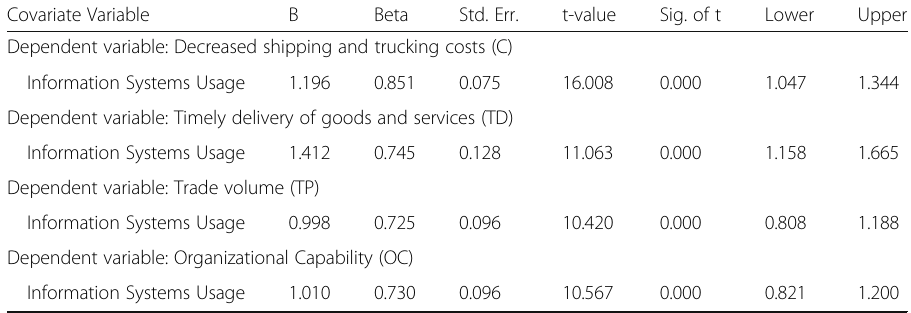
Table 10 Canonical Solution for Information Systems Usage on Logistics Performance Covariate Variable B Beta Std. Err. t-value